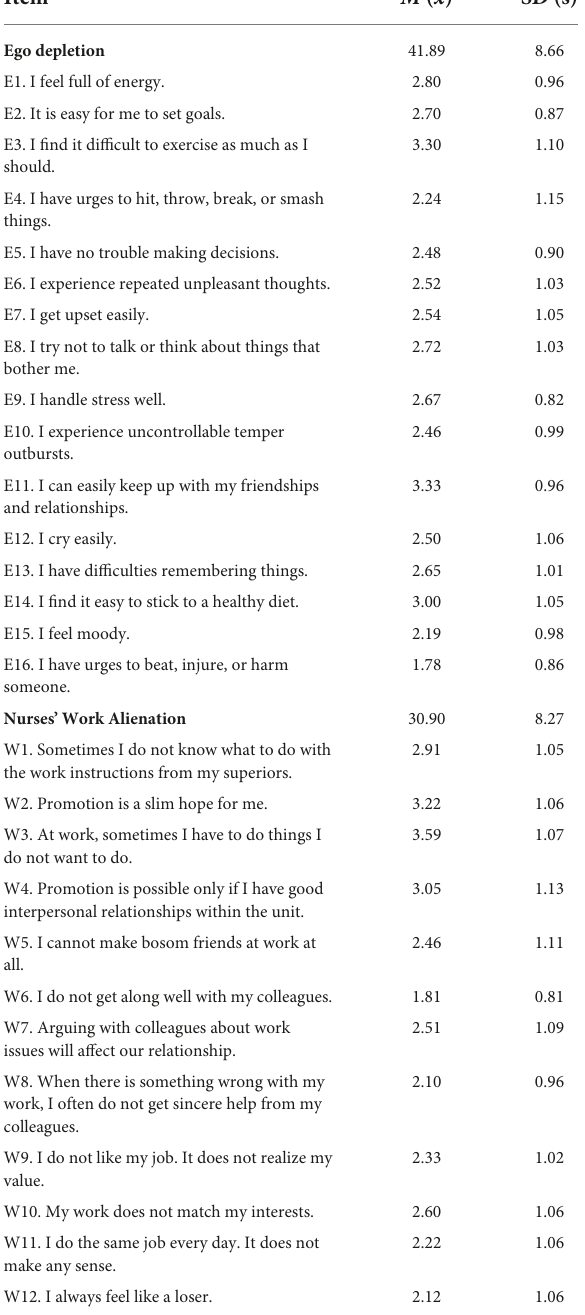
TABLE 2 Statistical results of the mean and standard deviation of items in the ego depletion and work alienation networks ( N = 353).